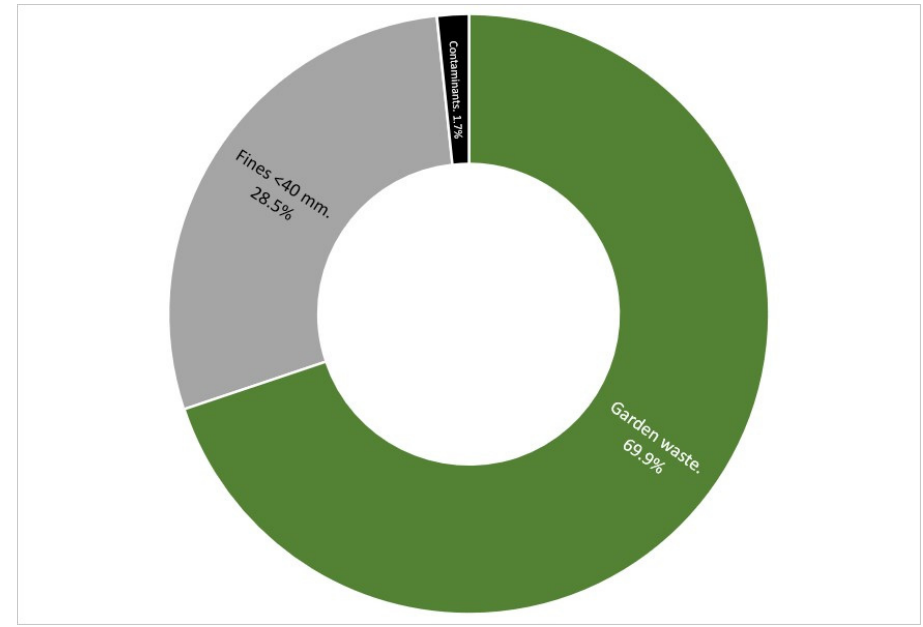
Figure 7. Composition of separately collected biowaste .